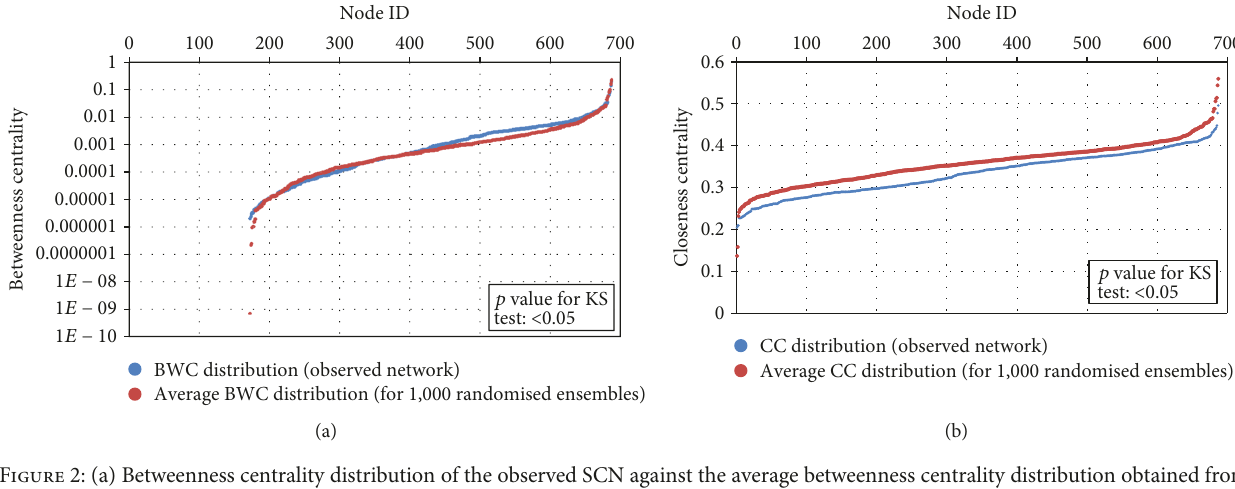
Figure 2: (a) Betweenness centrality distribution of the observed SCN against the average betweenness centrality distribution obtained from 1000 randomised ensembles. (b) Closeness centrality distribution of the observed SCN against the average closeness centrality distribution obtained from 1000 randomised